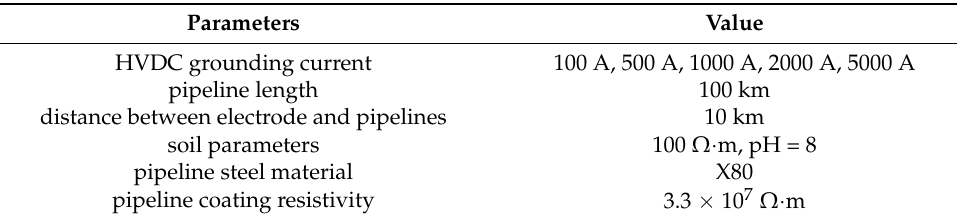
Table 1. Parameters for the study